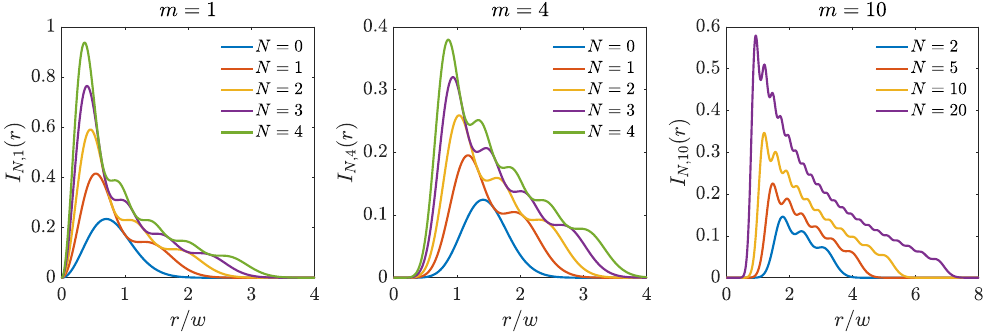
Figure 1. Intensity profiles I Nm given by Equation (35) for several values of N and m (as indicated in Figure